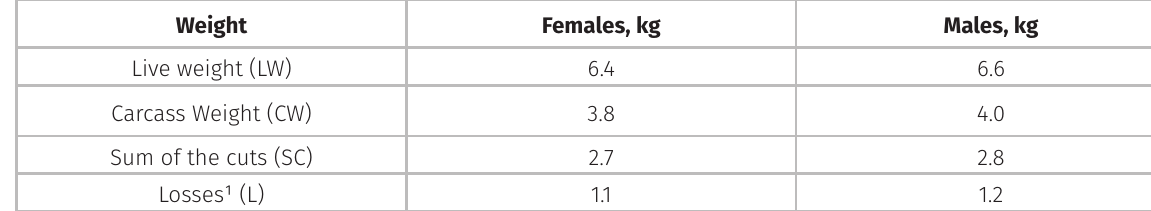
Table II. Weight from animal processing of the caimans separated by sex (females and males).